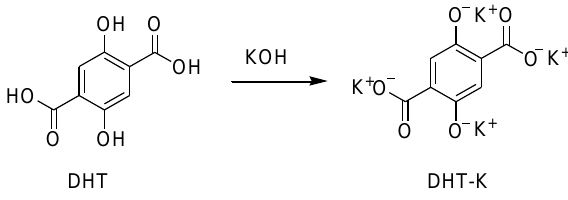
Scheme 1. Synthesis of DHT-K.